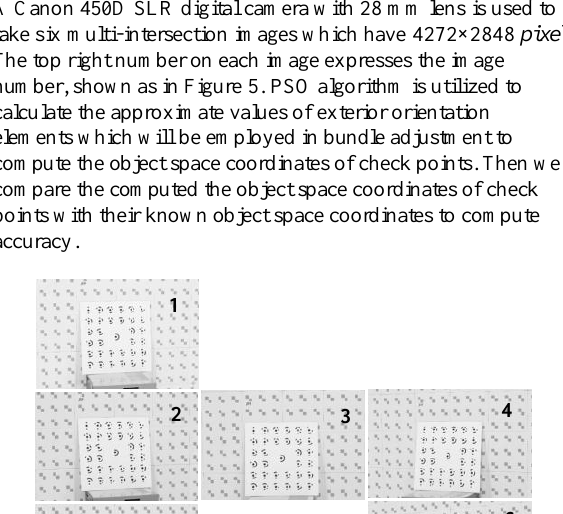
Figure 4. Diagram of control points and check points distribution (a) three control points and check points (b) six control points Table 2. Exterior orientation elements calculated by PSO and Bundle adjustment (three control points)